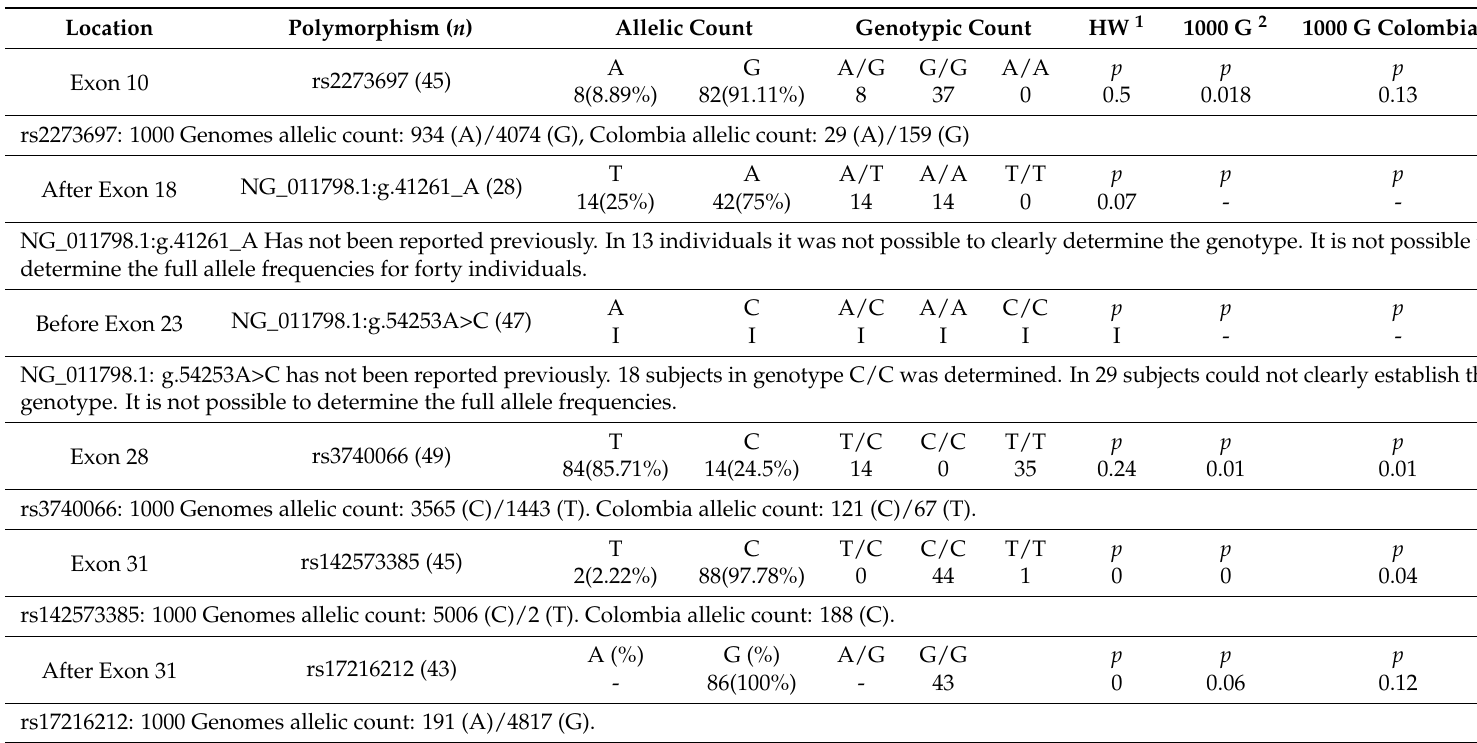
Table 4. The polymorphism ABCC2 ATP-binding cassette, sub-family C (CFTR/MRP), member